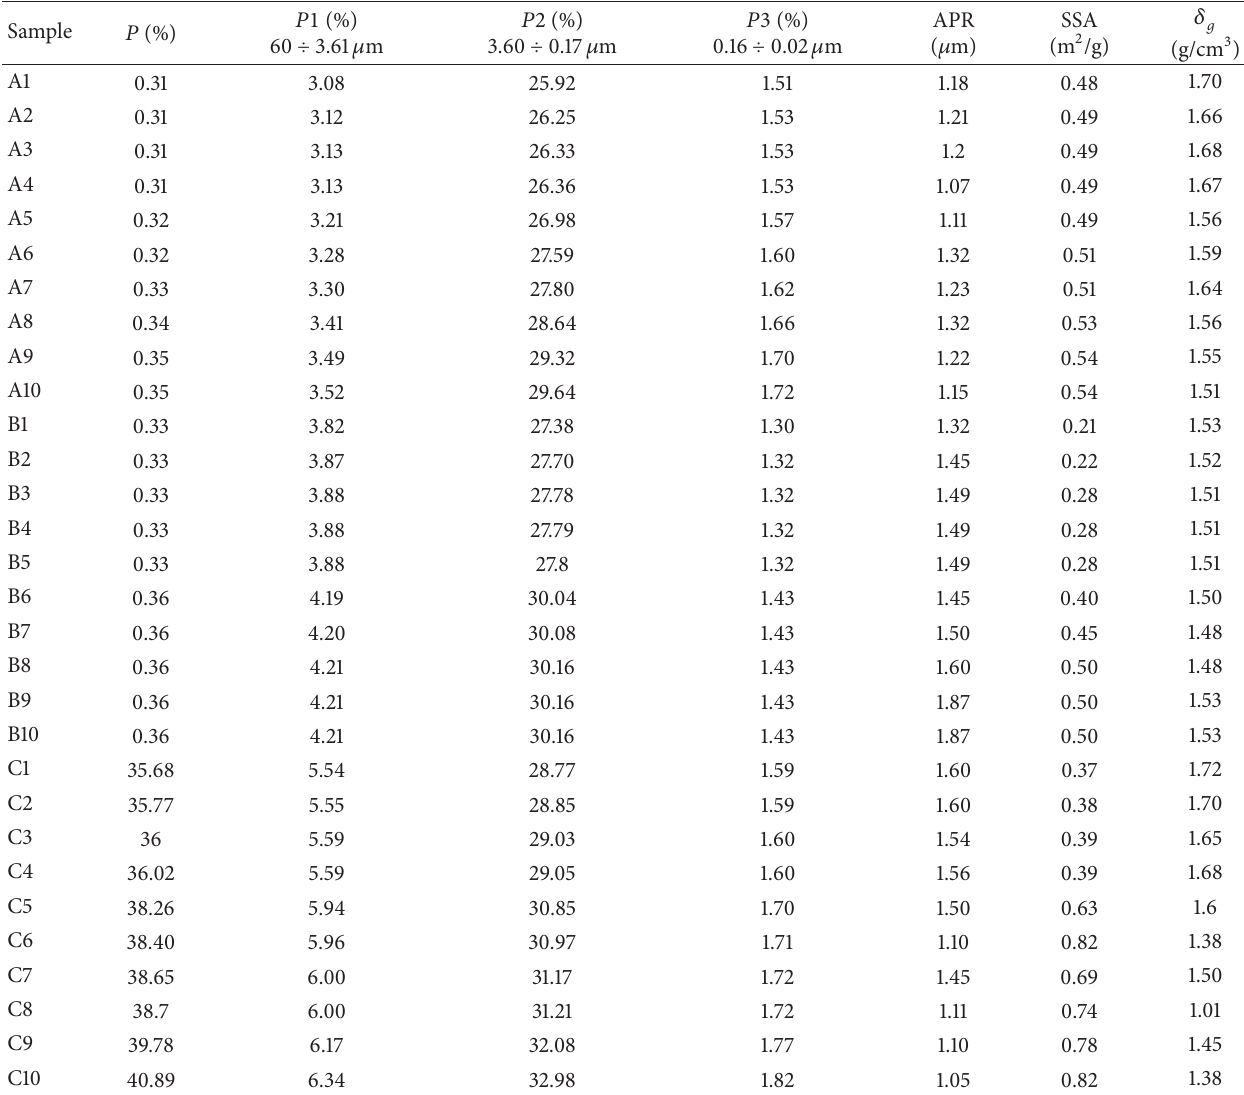
Table 1: Microstructural characteristics of the samples. Total pore volume ( 𝑃 ), porosity in the first range ( 𝑃1 ), porosity in the second range ( 𝑃2 ), porosity in the third range ( 𝑃3 ), average pore radius (APR), specific surface area (SSA), and bulk density ( 𝛿 𝑔 ).